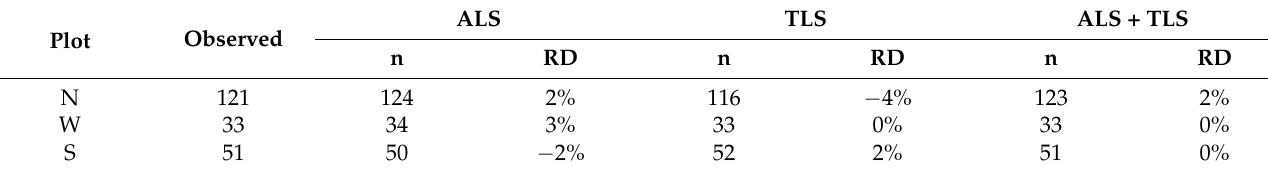
Table 4. Result of the individual tree detection (ITD) using ALS, TSL, and the fused (ALS + TLS) lidar datasets; n = number of detected trees; RD = relative difference between detected and observed trees relative to the number of observed trees (detection error).